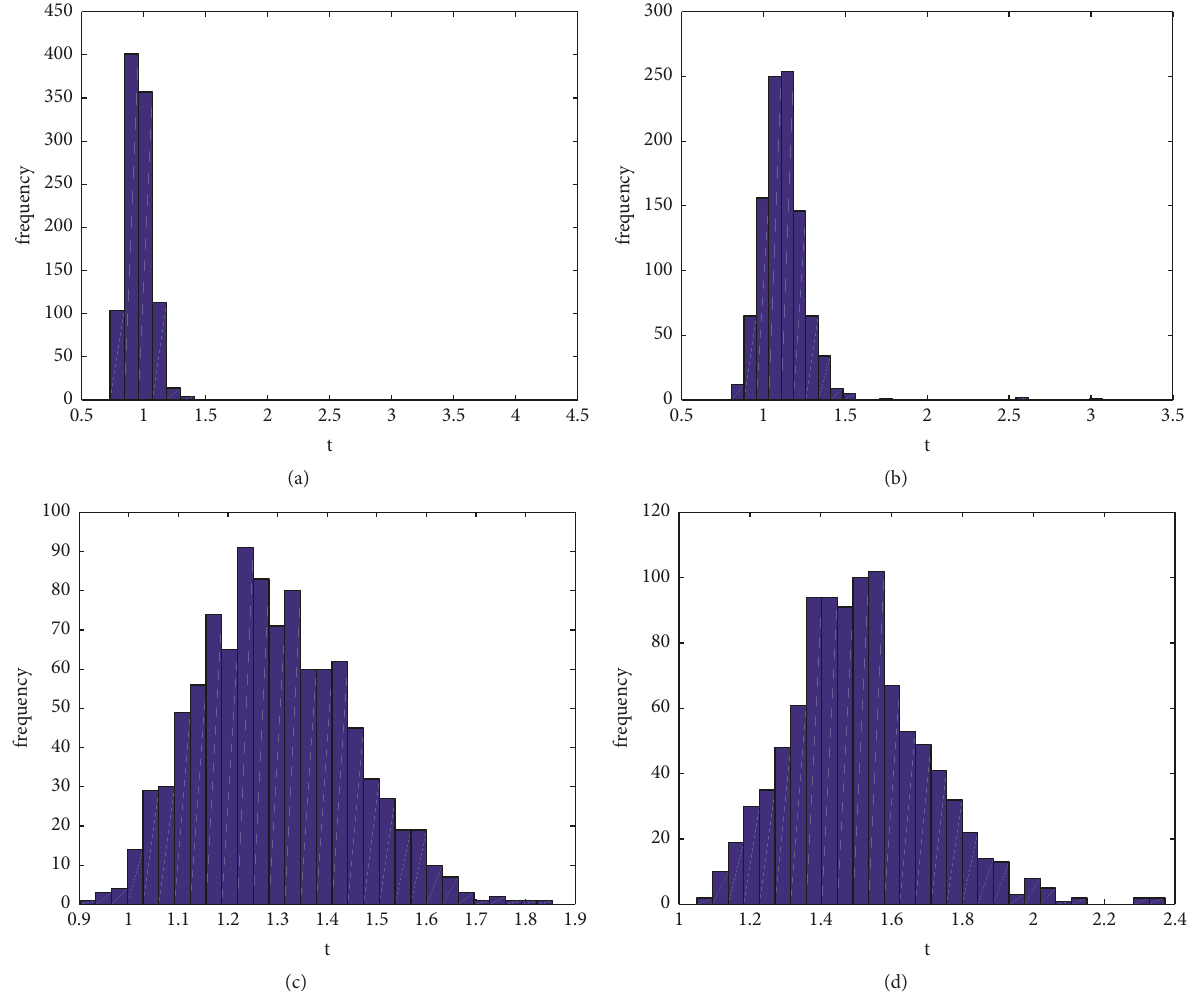
Figure 6: The effects of ET on pest-outbreak frequency; parameters are fixed as 𝑟 = 1, 𝐾 = 10,𝑎 = 2,𝜇 = 0.2, 𝐷 = 0.1,𝜃 = 0.4, 𝜏 = 0, 𝛼 1 = 0.3,𝛼 = 0.25 , and (a) 𝐸𝑇 = 4.5 ; (b) 𝐸𝑇 = 5.5 ; (c) 𝐸𝑇 = 6.5 ; (d) 𝐸𝑇 = 7.5 2